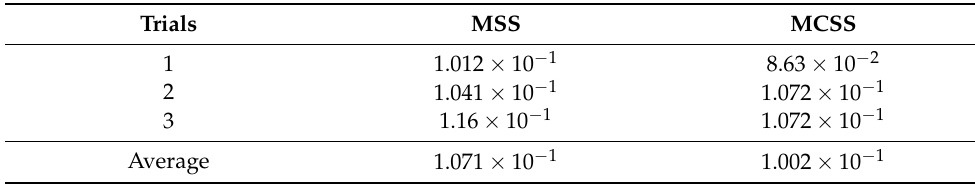
Table 6. Uncoded BER of signals with Doppler